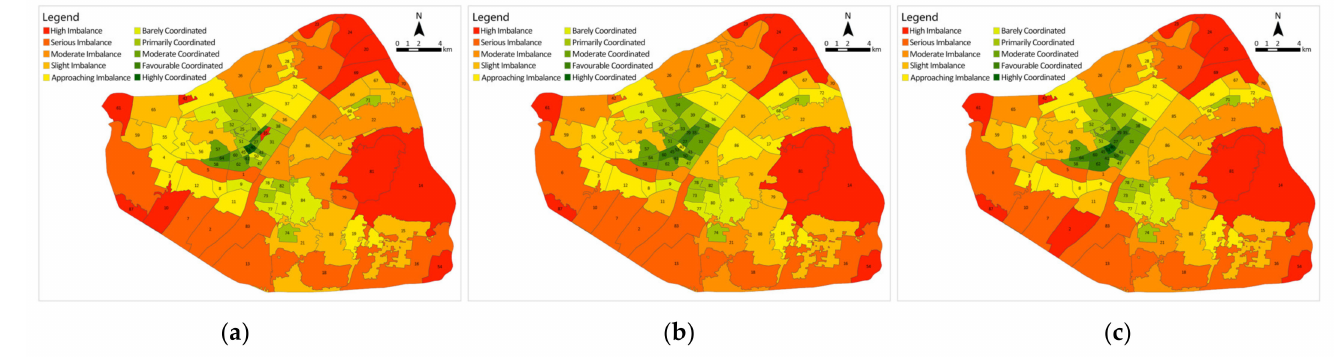
Figure 12. Coordinated development level assessment of subdistricts: ( a ) Stage A; ( b ) Stage B; ( c ) Stage